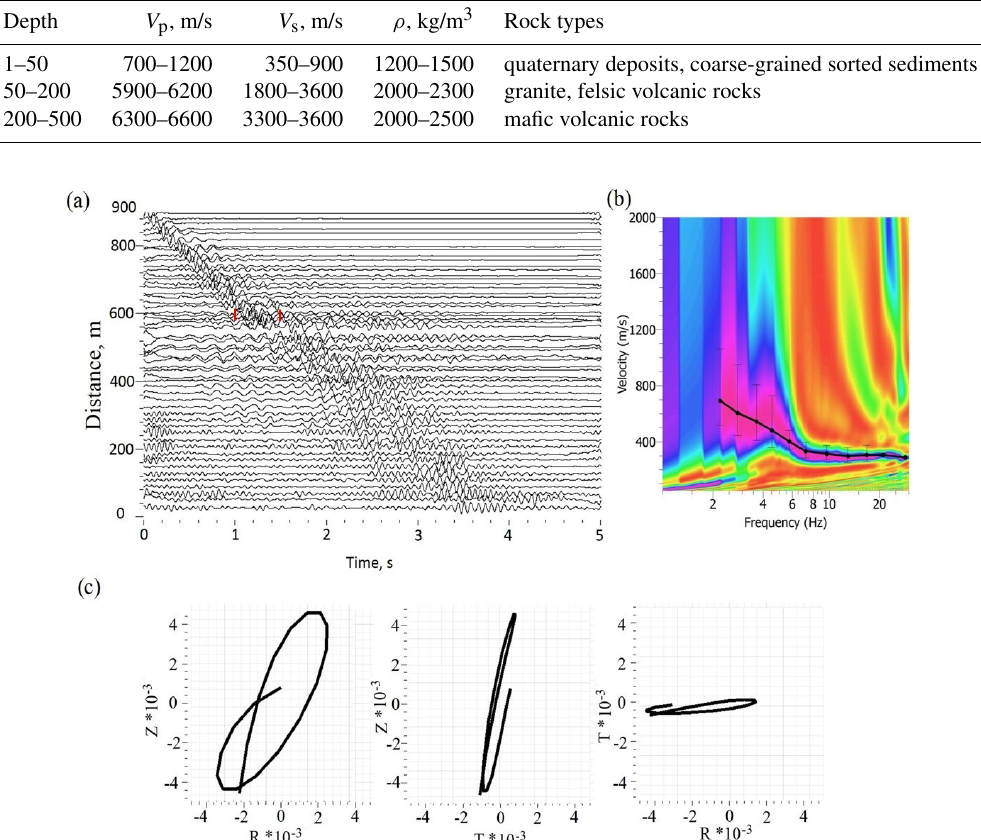
Figure 11. Example of EGFs with the correspondent dispersion curve, obtained from passive seismic data for the high-resolution profile shown in Fig. 9: (a) EGFs; (b) dispersion curve, extracted by the multichannel analysis of surface waves (MASW) technique; (c) particle motion diagrams for part of EGF indicated in panel (a) by red